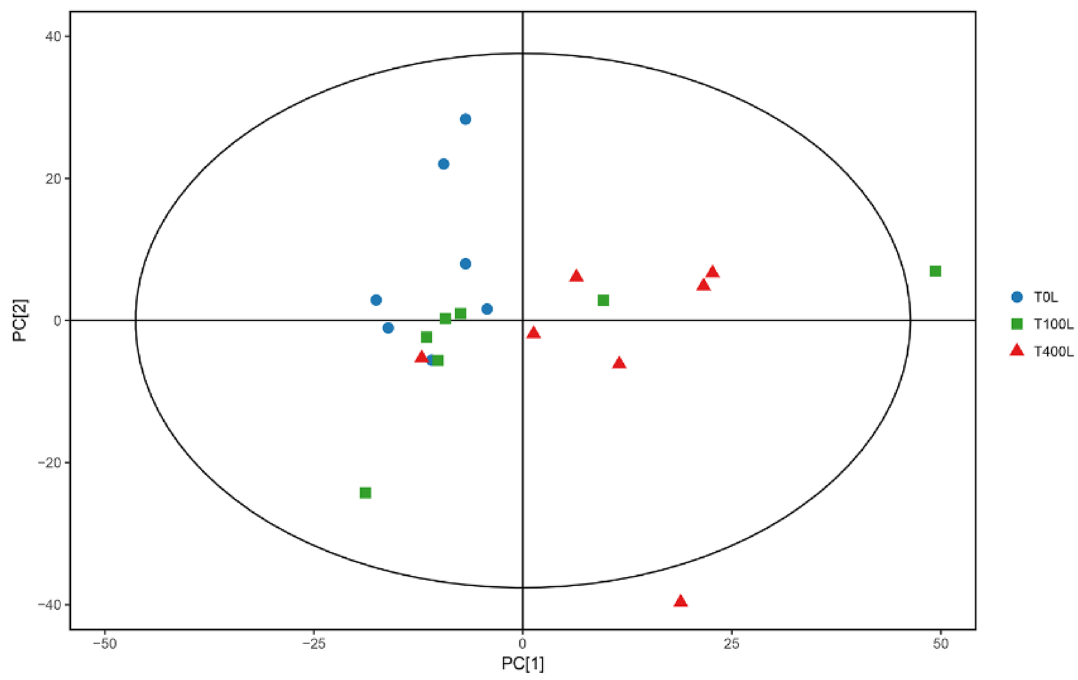
Figure 4. Principal component analysis (PCA) score plots of metabolic profiles in the leaves of seedlings under salt